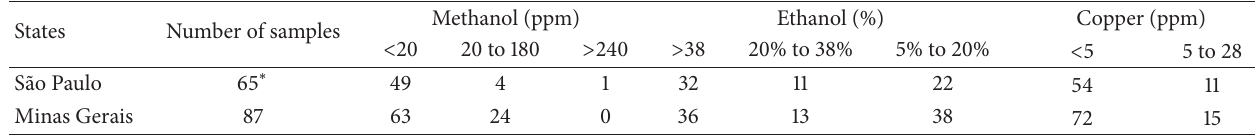
Table 2: Results obtained in chemical analyses carried out in 65 samples of alcoholic beverages from state of S˜ao Paulo ∗ and 87 from state of Minas Gerais, Brazil. Methanol content (limit 200 ppm), ethanol content in percentage by volume (38% to 48%), and copper (limit 5 ppm). States